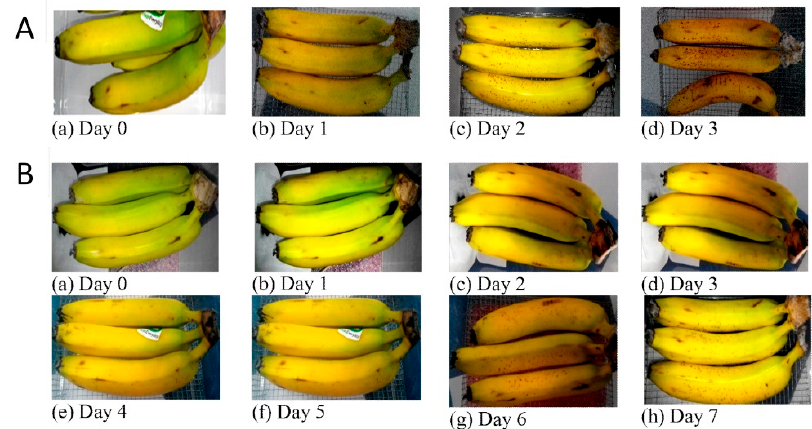
Figure 4. Images of Cavendish banana as the fruit model during the preservation test. Case of without adsorbent ( A ) and in the presence of adsorbent ( B ). Condition: 25 °C temperature and 80% relative humidity.